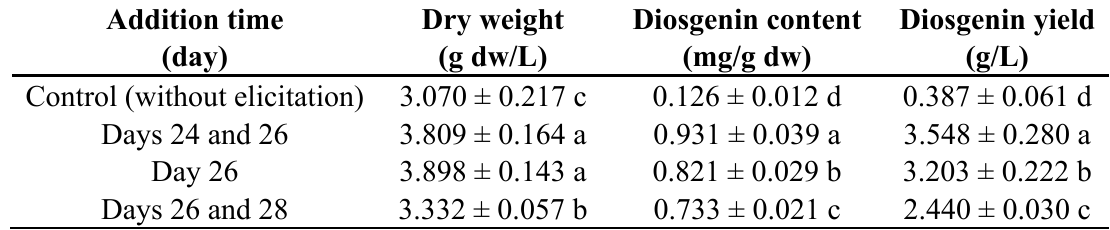
Table 1. Effects of repeated elicitation with DP7 at 6 mg/L on growth and diosgenin accumulation of D. zingiberensis cell cultures.